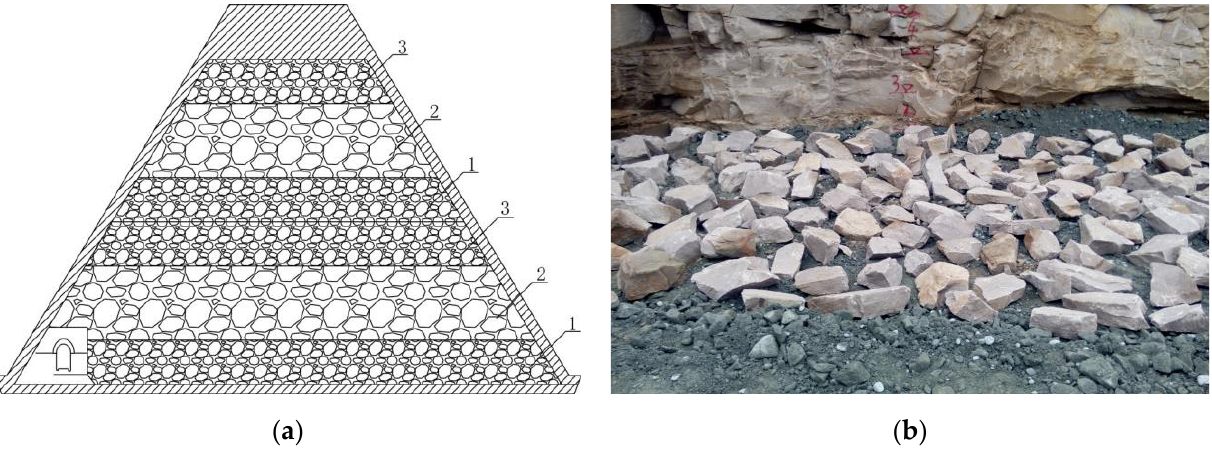
Figure 6. Cemented sand and gravel and cemented rockfill: ( a ) schematic diagram of the structure of the cemented rockfill dam and ( b ) laying test of the cemented rockfill material. Note: 1 is the first layer of cemented sand and gravel; 2 is the cemented rockfill layer; and 3 is the second layer of cemented sand and gravel.